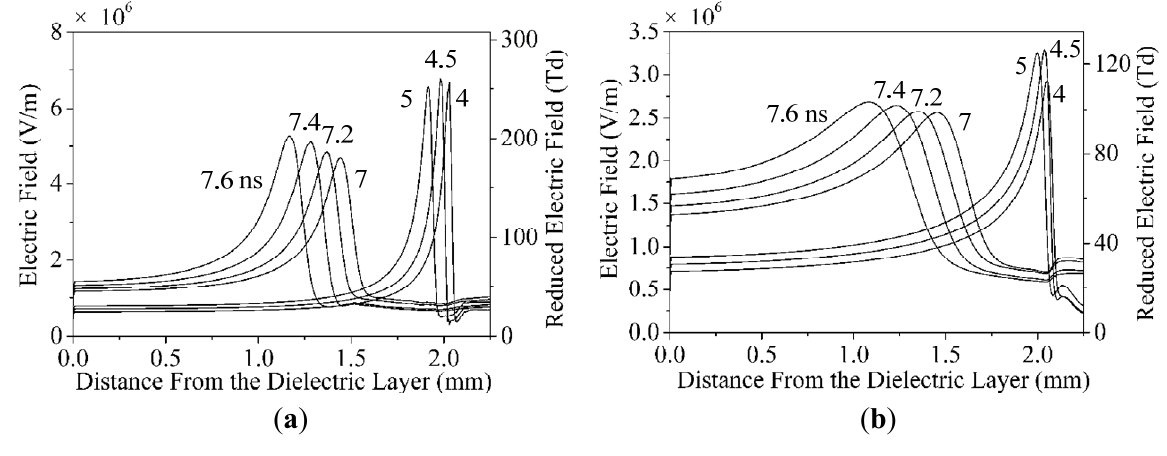
Figure 8. The electric field distribution along axis in streamer propagation for TNG at various times: ( a ) MN; ( b )